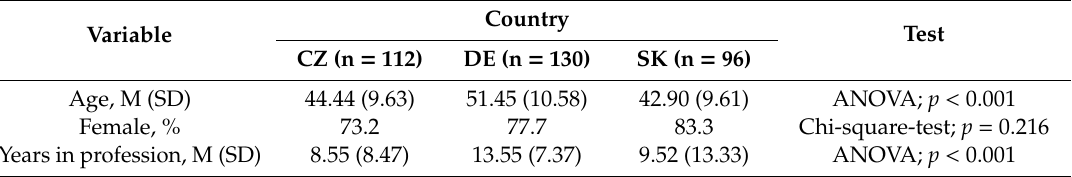
Table 1. Age, gender and years in profession in Czech (CZ), German (DE) and Slovak (SK) psychotherapists.